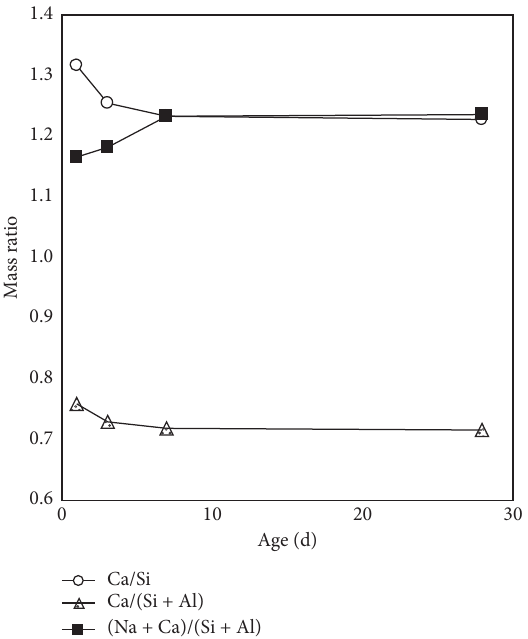
Figure 12: Analysis of the mass ratio of elements in an alkali- activated nickel slag activated with Na 2 SiO 3 /Na 2 CO 3